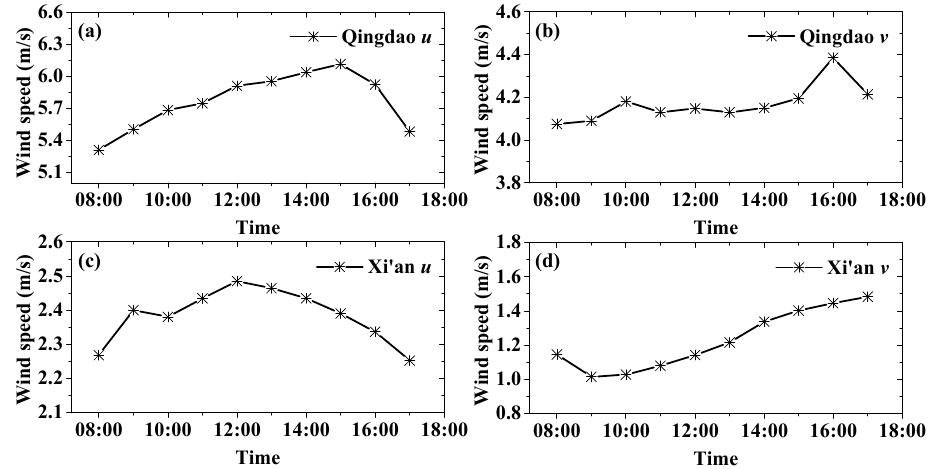
Figure 12. Diurnal variations of the wind speed: the ( a ) u wind and ( b ) v wind of Qingdao, as well as the ( c ) u wind and ( d ) v wind of Xi’an.